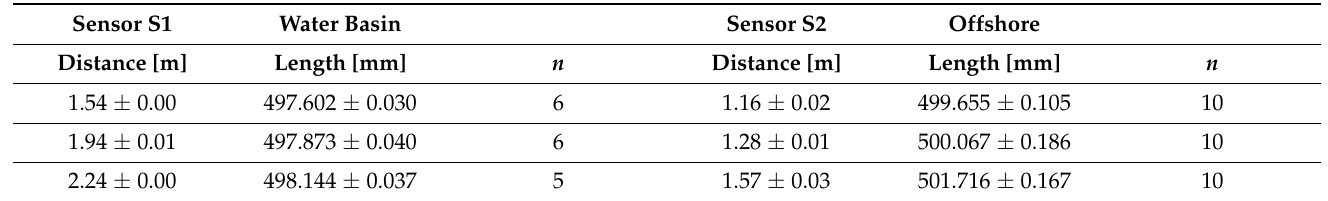
Table 1. Length error of repeated ball-bar measurements in the water basin and offshore. The calibrated length of ball-bar was 497.612